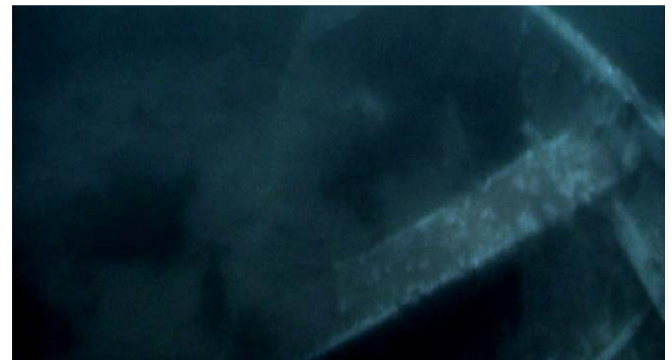
Figure 5. The Return (2003).